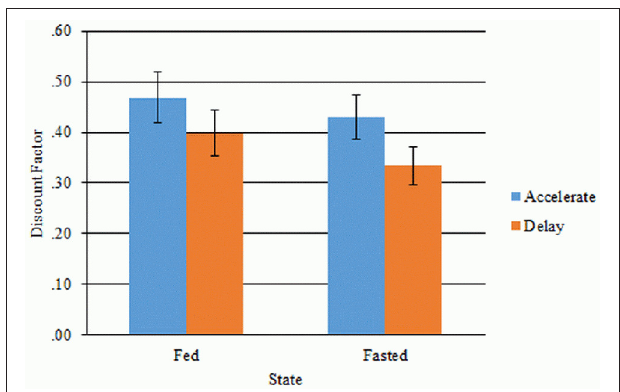
FIGURE 1 | Discount factors for the accelerate and delay frame in the fed and fasted state. Error bars denote standard errors.